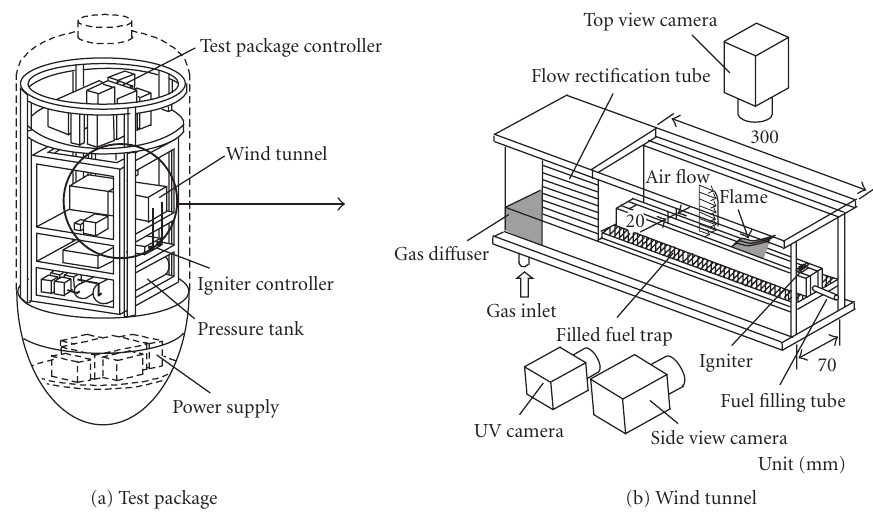
Figure 6: Experimental apparatus for a shallow liquid pool in